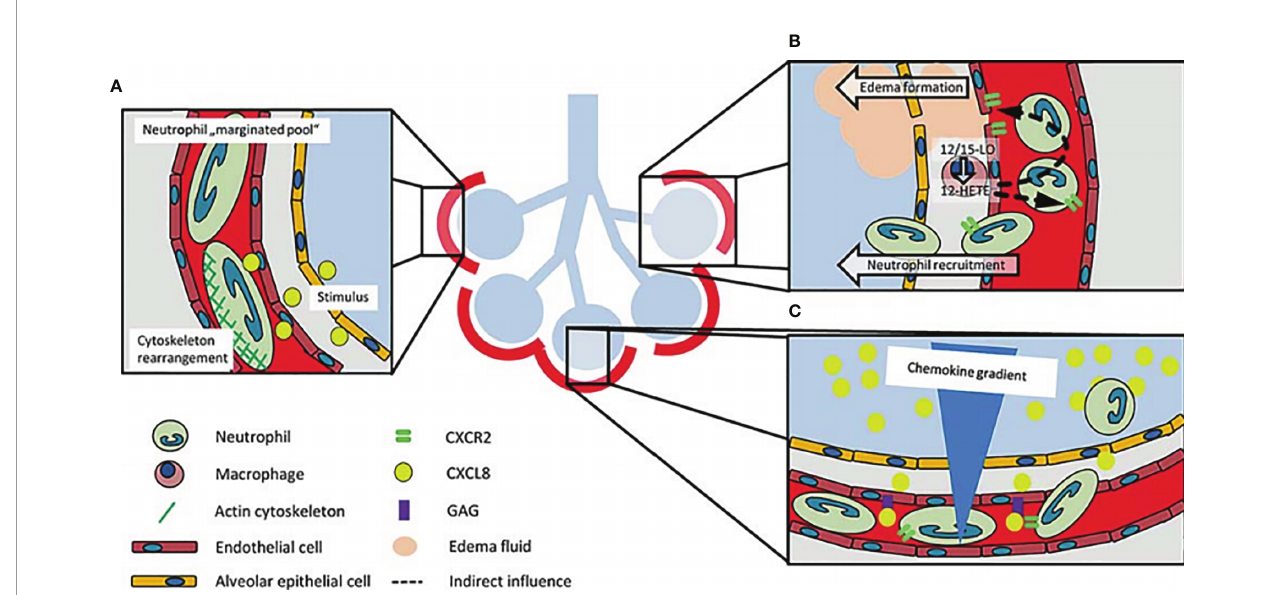
FIGURE 1 | Schematic representation of how neutrophils are recruited to the lung. (A) Neutrophils change their shapes in order to move across the capillary bed because of the small nature of the lung capillaries. The increase in time required by neutrophils to transit in the lungs accounts for the name ‘ marginated pool of neutrophils ’ . Neutrophil stiffening by cytoskeleton rearrangement after stimulation participates in neutrophil recruitment into the lung. (B) 12-HETE, a lipid mediator made by 12/15-LO in lung macrophages regulates the balance of chemokine-chemokine receptors and increases vascular permeability and neutrophil recruitment in the lungs. (C) The increase in chemokine concentration gradient in the alveolar region coupled with the presentation of chemokines by glycosaminoglycans, modulates the recruitment of neutrophils to this region of the lung